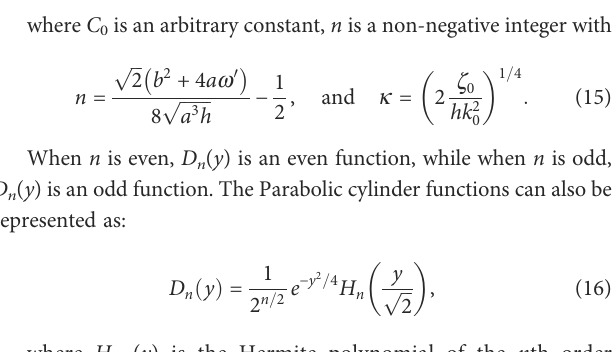
ffiffiffi p hk 2 = z : 2,1,5, respectively. Shaded areas indicate negative 2 0 = 0 0